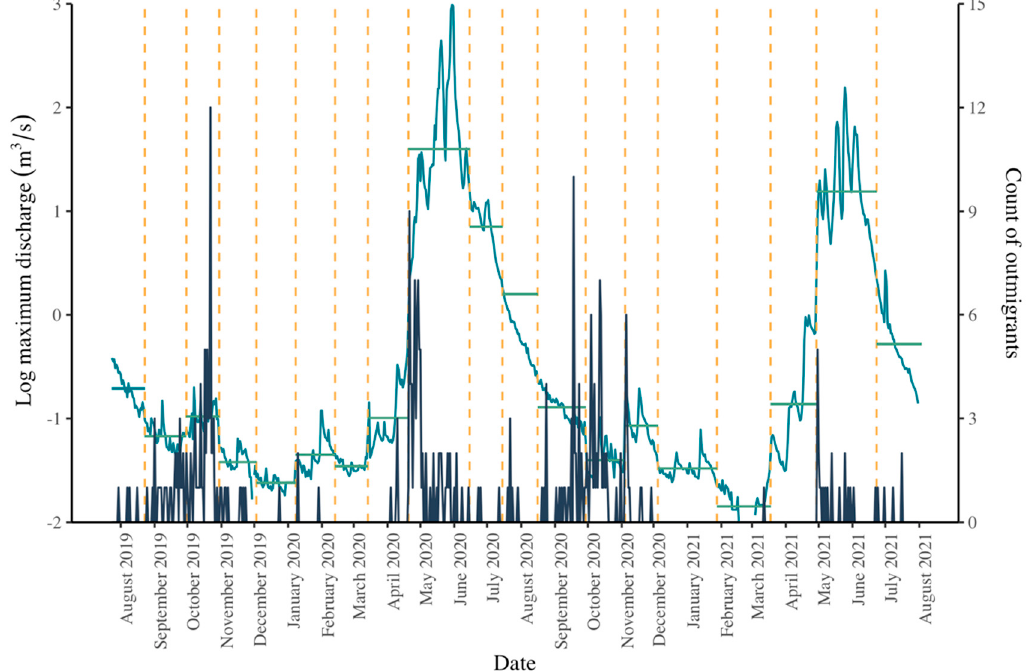
Figure 6. Time series from Graves Creek, Montana, from 25 July 2019 through 1 August 2021, with light blue lines delineating time series of natural log-maximum daily discharge (cubic meters per second; m 3 /s) and dark blue lines delineating time series of bull trout out-migrating by day. Dotted yellow lines delineate changepoints, and green horizontal lines represent the mean for each segment between the changepoints.